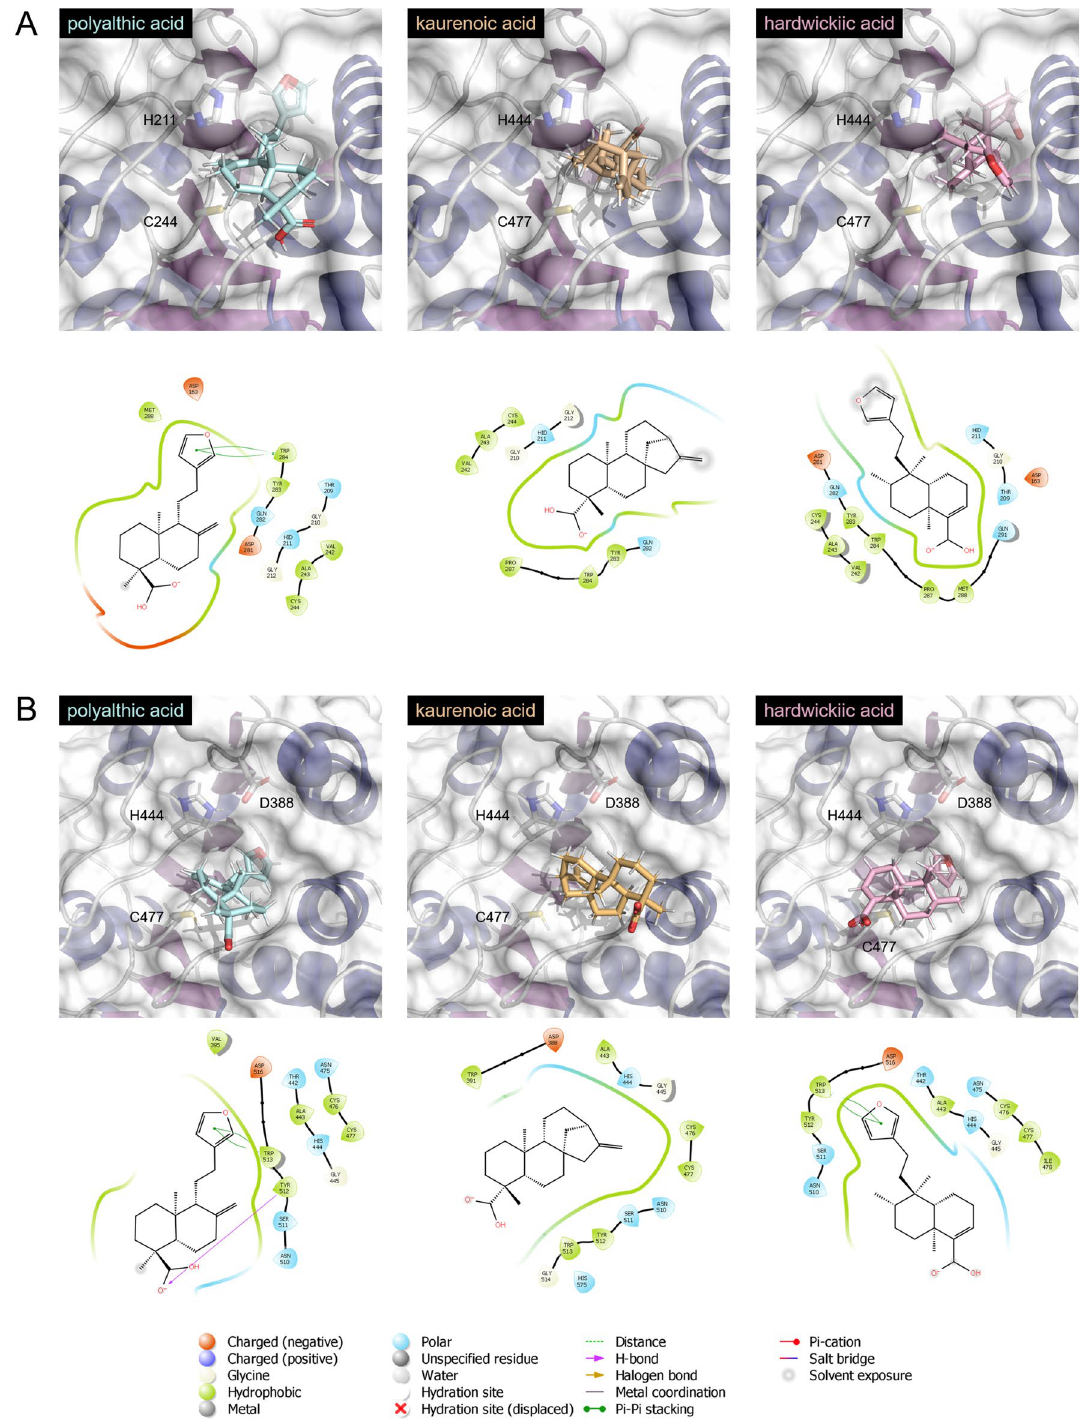
Figure 5. The interaction of the isolated compounds kaurenoic acid, polyalthic acid, and hardwickiic acid with the active sites of the enzymes ( A ). Arg-X (PDB ID 1CVR) and ( B ). Lis-X gingipain (PDB ID 6I9A) from P. gingivalis was evaluated my molecular docking using the GOLD 42,43 . The active sites of each enzyme are also shown. For Arg-X, H444 and C477 form the the catalytic dyad, while for the Lis-X enzyme the catalytic triad is composed by H444, C477 and D388, as shown in recent studies 4 . Ligand interaction diagrams (LIDs) shown in details the intermolecular interactions in each case. LIDs were prepared with Maestro Release 2020-2, Schrödinger, LLC, New York, NY,